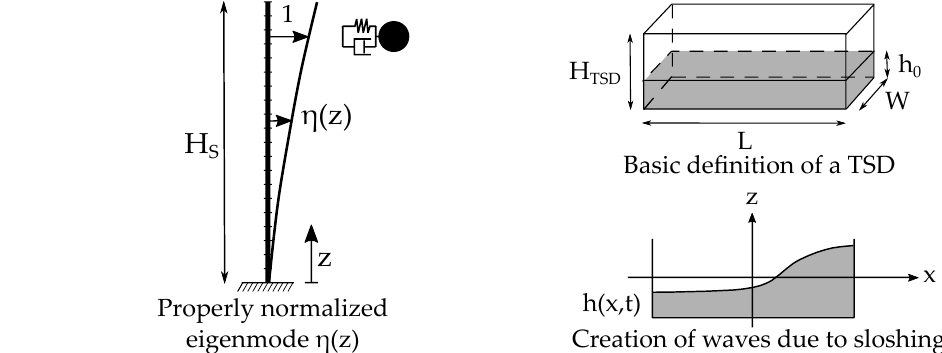
Figure 1. Scheme of a TMD attached to a structure ( left ) and the main parameters for defining a TSD ( right